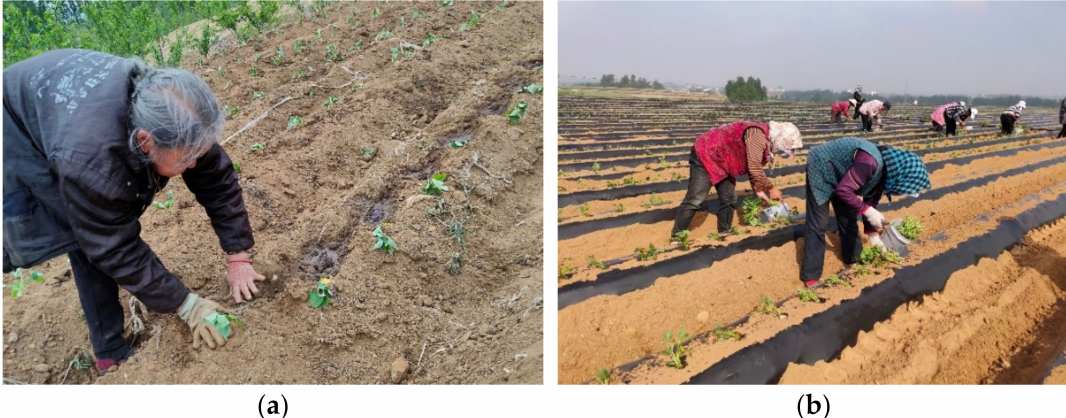
Figure 1. Sweet potato slips are planted manually in the raised beds (RB) and raised beds mulched